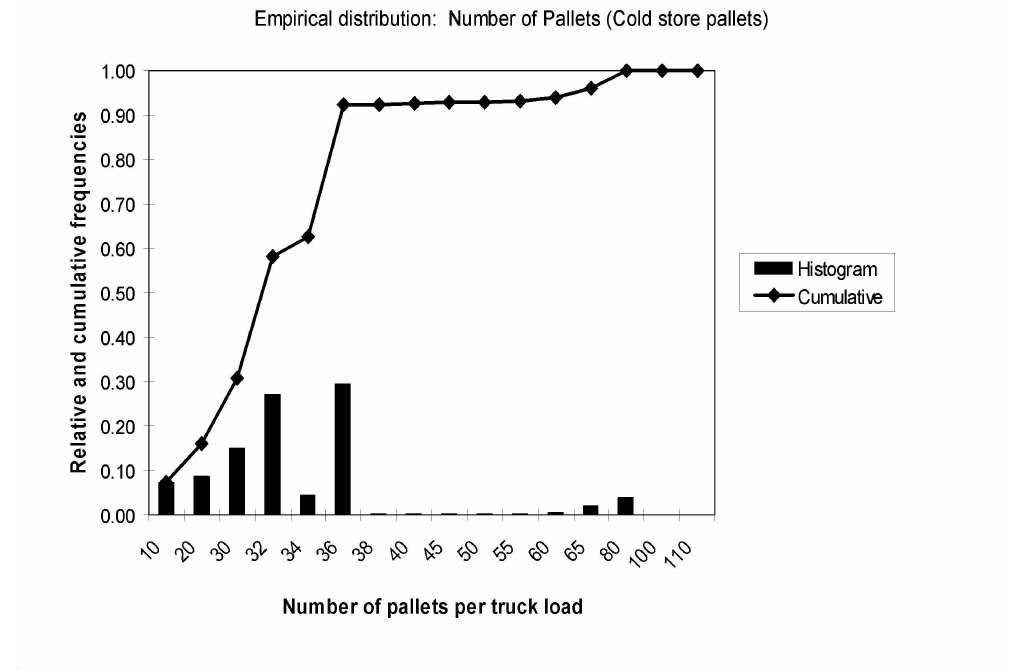
Figure 5: Histogram and empirical distribution: Number of pallets (Cold